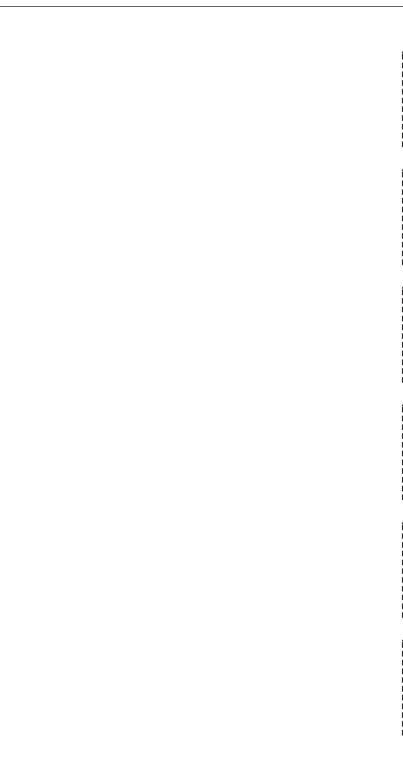
( Figure 2H ) and GEO ( Figure 2I ) databases. Above all, we successfully found 12 vital ECSRGs for further analysis.